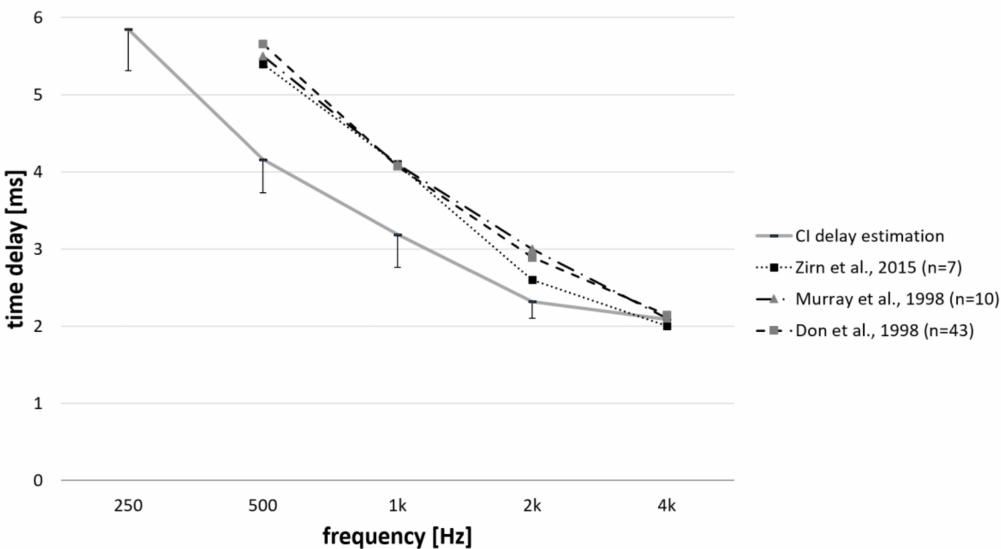
Figure 8. CI delay estimation. The mean and standard deviation for the latency when the CM reached 10% of the maximum amplitude and summation of the time necessary to release neurotransmitters into the synaptic cleft as measured by Temchin et al., 2005 (grey line); compared with previous work on CI delay estimation by Don et al., 1998 [43] (dotted-dashed line); Murray et al., 1998 (dashed line); and Zirn et al., 2015 [5] (dotted